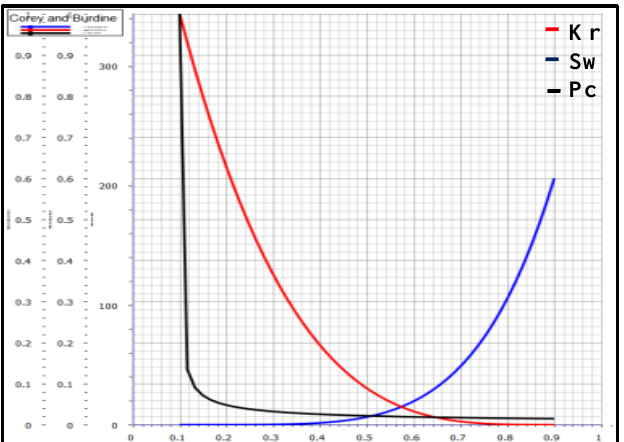
Fig. 3. SEM micrographs depicting increase in fractures with various values of confining stress (a) 25 psi (b) 50 psi